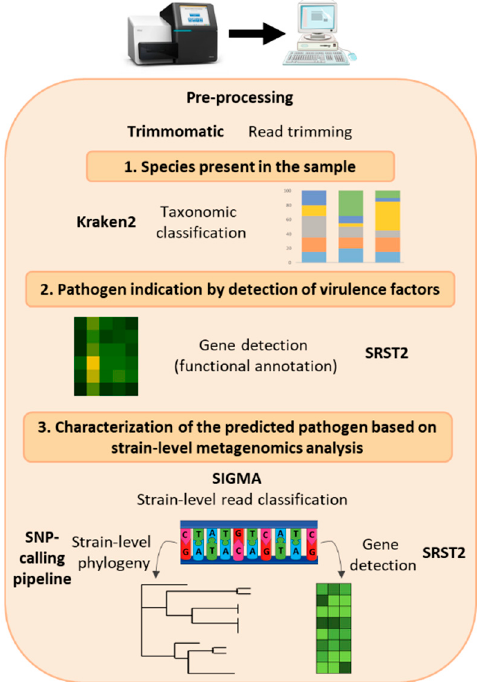
Figure 2. Presentation of the bioinformatics analysis for the characterization of STEC in samples using a metagenomics approach. After sequencing and pre-processing of the reads, first, the species in the sample are detected by a taxonomic classification tool (Kraken2); then, the presence of a pathogen in the sample is predicted based on the detection of virulence genes in the reads (SRST2), after which individual bacterial strains are inferred (Sigma) and characterized with gene detection (SRST2) and single nucleotide polymorphism (SNP) phylogeny (SNP-calling pipeline).